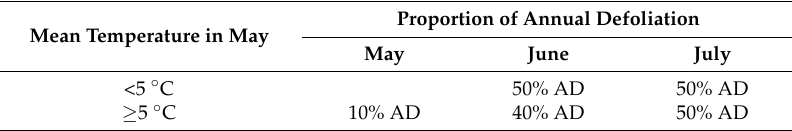
Table 2. Monthly distribution of annual defoliation (AD) in May, June, and July based on the mean temperature in May.